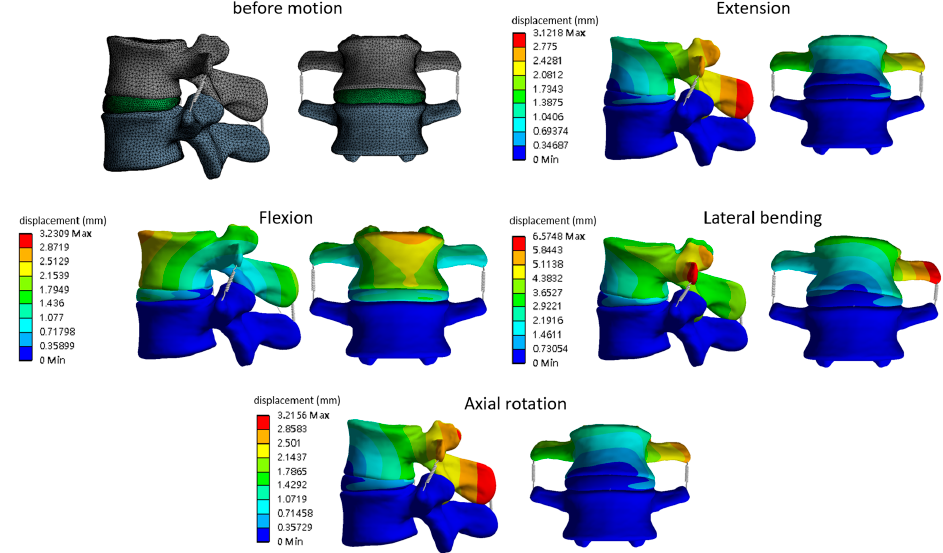
Figure 5. displacement on the finite element model (model b) during different